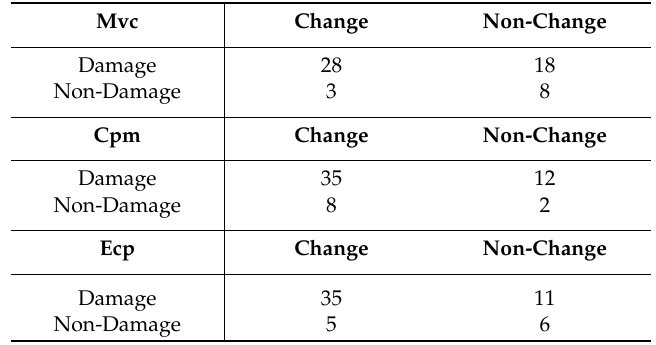
Table 4. Accuracy of detection.